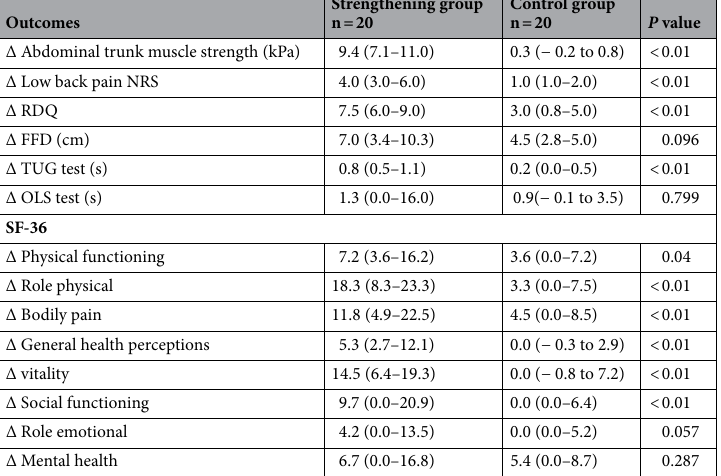
Table 3. Comparison of the improvement after 12-week intervention between each group. Data are shown as the median and interquartile range. NRS numerical rating scale, RDQ The Roland Morris Disability Questionnaire, FFD Finger-floor distance, TUG Timed up and go, OLS one-leg standing, SF‑36 Short-Form